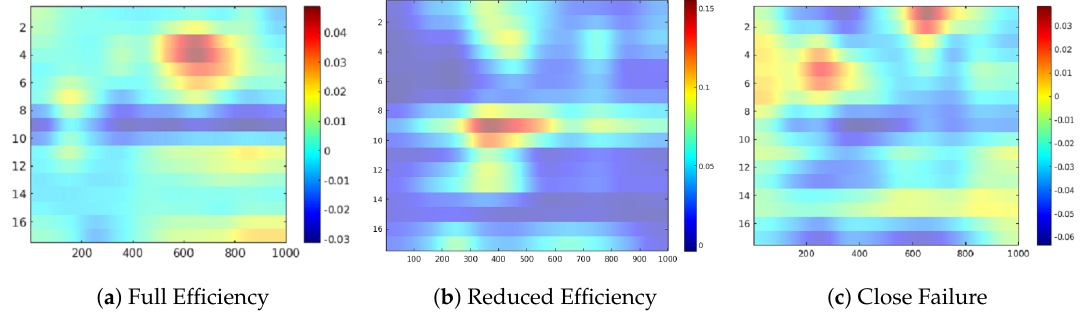
Figure 7. Feature attribution heatmap for the Cooler condition.